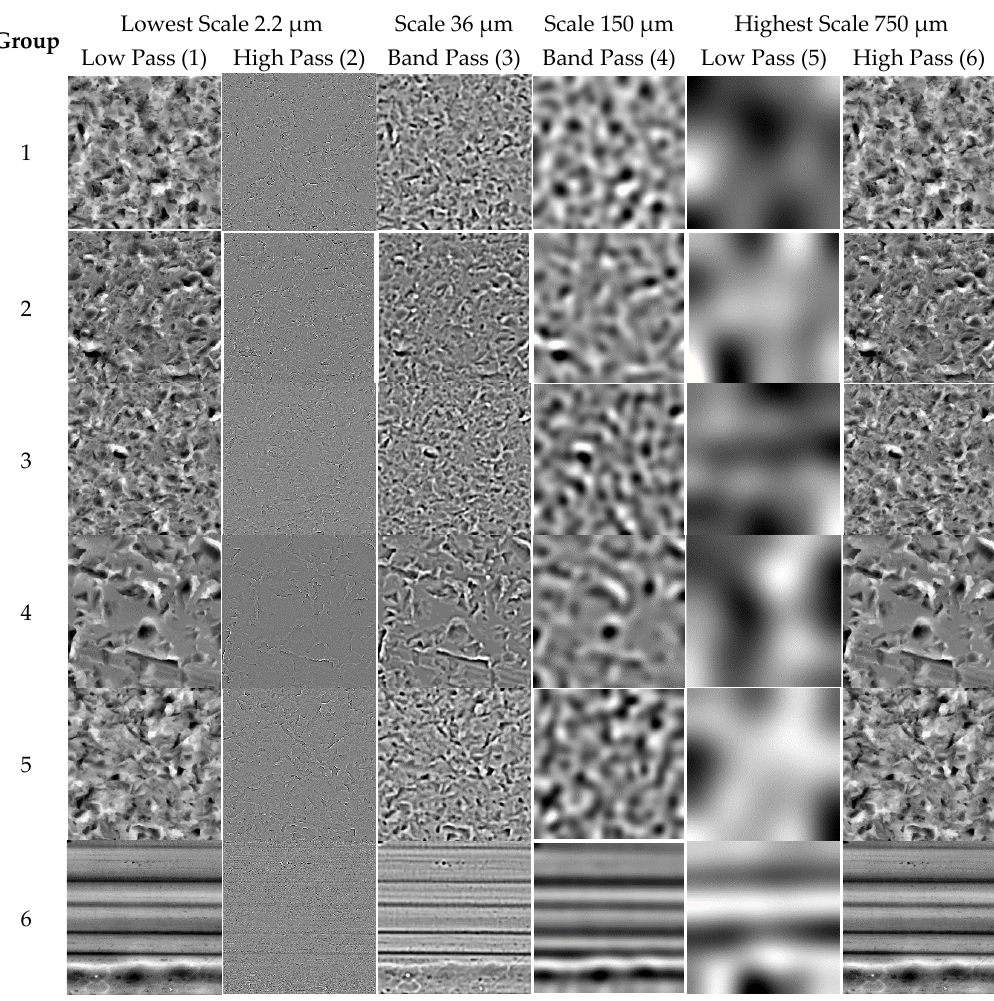
Figure 8 . One image (resolution of 1024 × 1024 pixels) from six mechanical material categories (1 to 6) with four different length scales and three filtering methods.